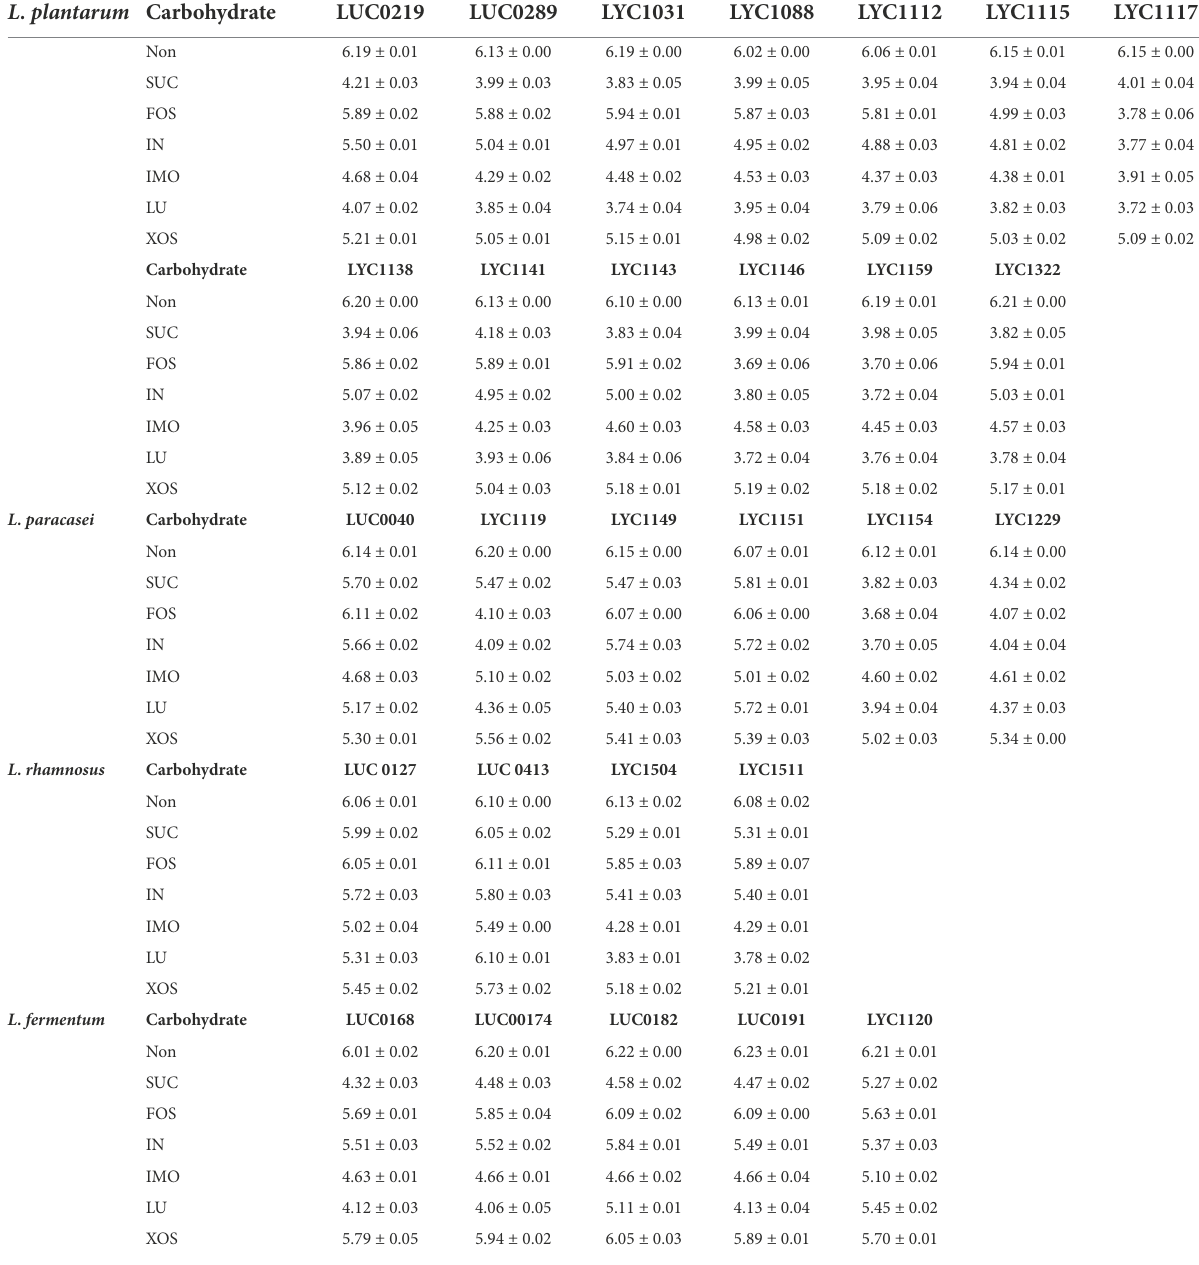
TABLE 2 The pH value of Lactobacillus strains cultured with MRS with different